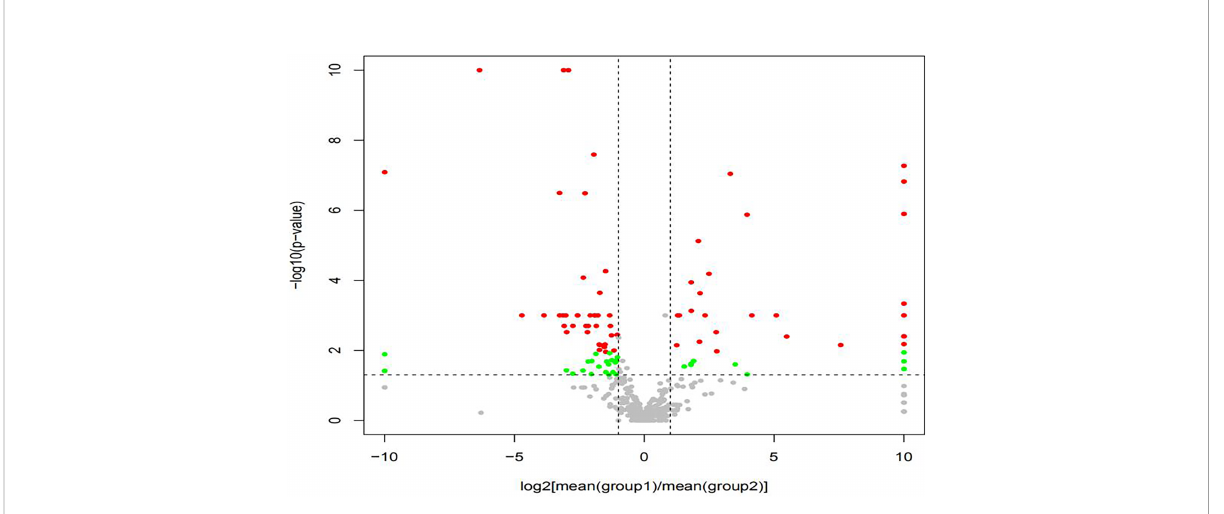
FIGURE 3 The volcano map showed the difference at genera level {Red dot: met log 2 [mean(A)/mean(B)] > 1 and p < 0.05 and q < 0.05 (advanced standard). green dot: only met log 2 [mean(A)/mean(B)] > 1 and p < 0.05 (primary standard). Gray dot: Taxonomy that did not meet any of the above criteria.}.